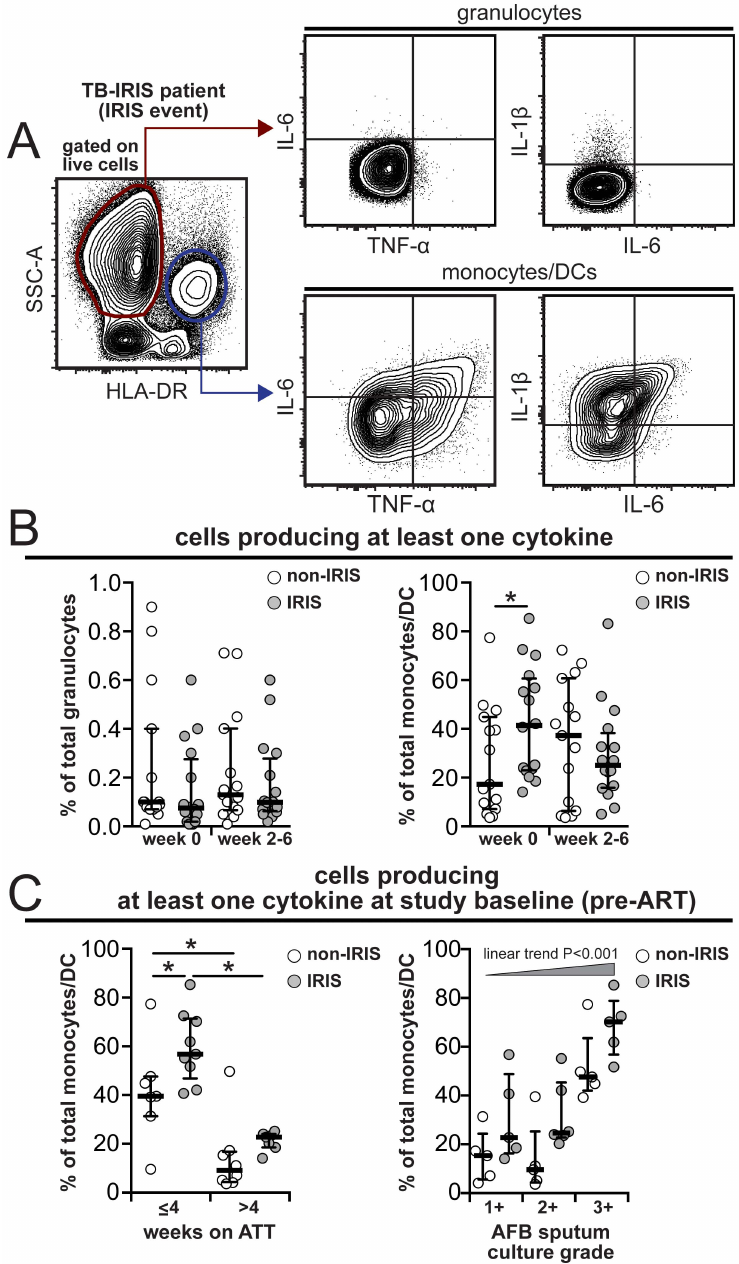
Figure 8. Increased frequency of monocytes spontaneously producing pro-inflammatory cytokines pre-ART in TB-IRIS patients. Whole blood intracellular cytokine assay was performed in 17 individuals from the IRIS group and 15 non-IRIS patients from the South Indian cohort. ( A ) Gating strategy to assess intracellular cytokine production by neutrophils and monocytes/DCs and ( B ) frequency of cells producing IL-1 b , IL-6 and/or TNF- a after 6 hour in vitro culture in the presence of brefeldin-A (unstimulated). ( C ) Pre-ART frequency of monocytes producing IL-1 b , IL-6 and/or TNF- a was compared between IRIS and non-IRIS patients stratified by time on ATT or M. tuberculosis loads in sputum cultures. Data were analyzed using Mann-Whitney or Wilcoxon matched-pairs test for paired analyses within each study group. * P , 0.05, ** P , 0.01, *** P ,